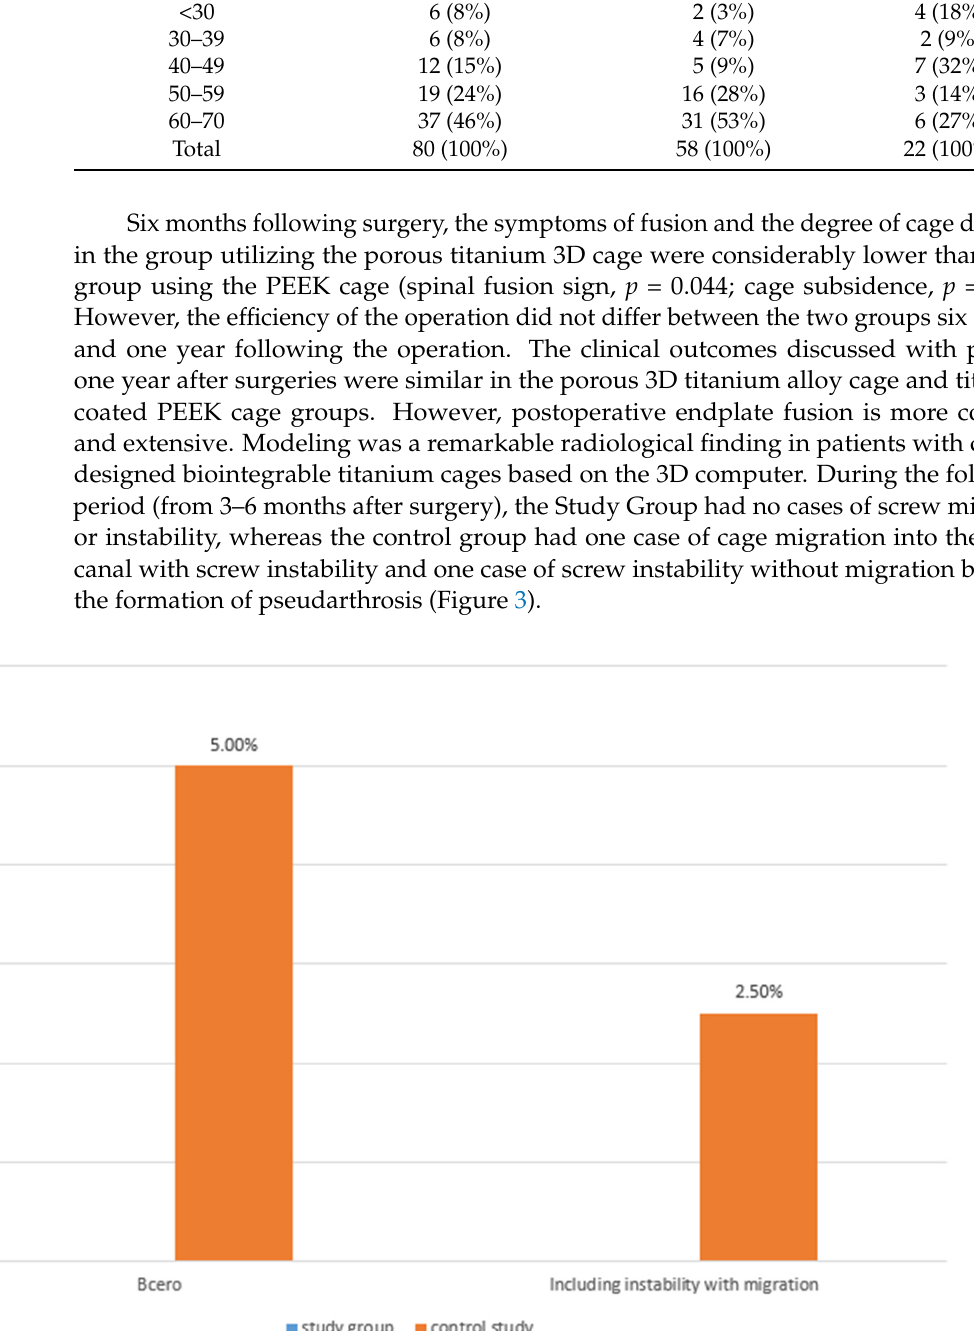
Table 1. Characteristics of study participants.